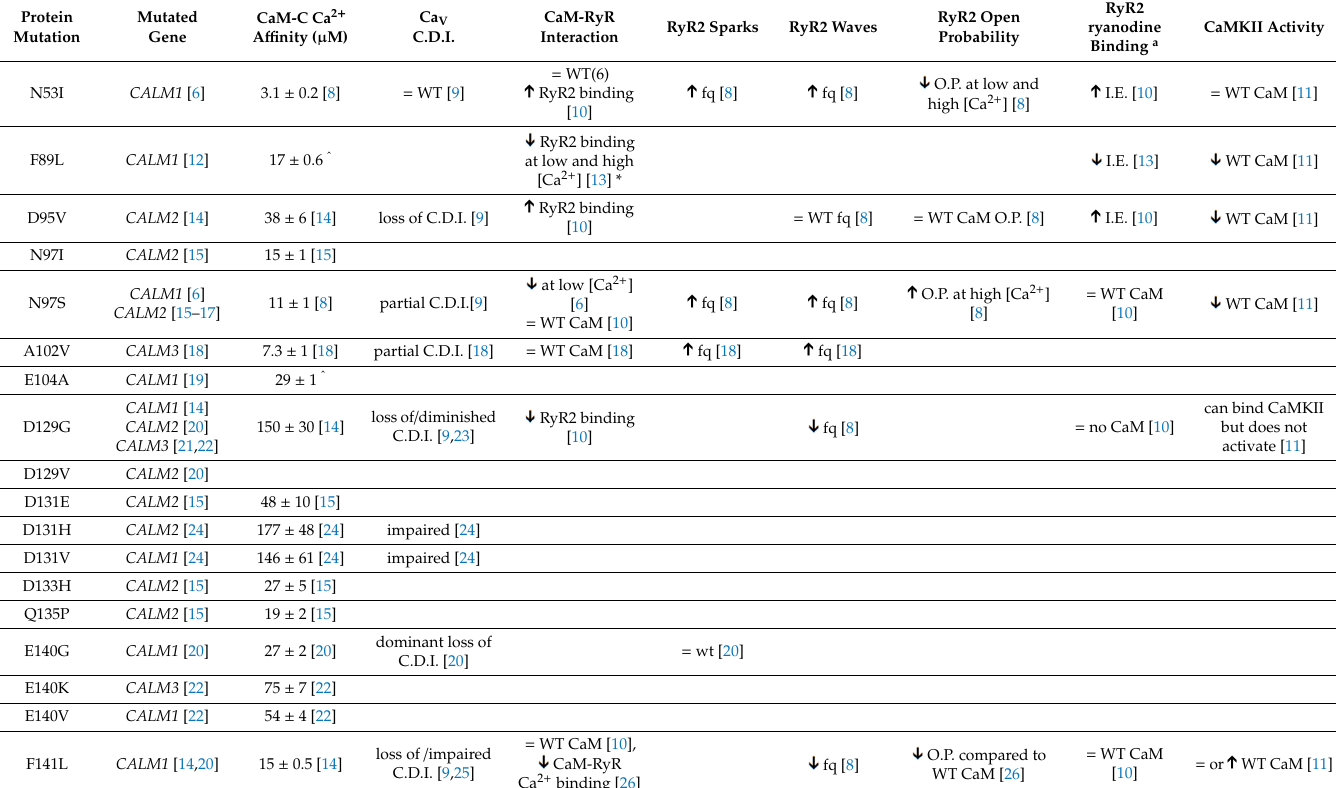
Table 1. Reported biophysical e ff ects of disease associated calmodulin (CaM)